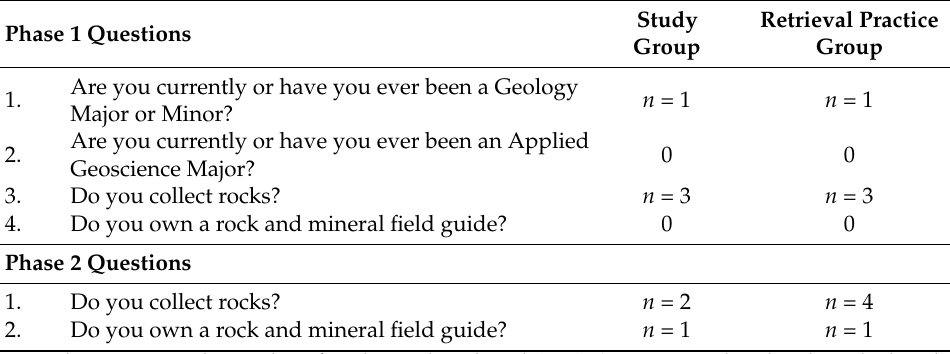
Table 1. Students’ Reponses to Prior Experience Questions at Phase 1 and Phase